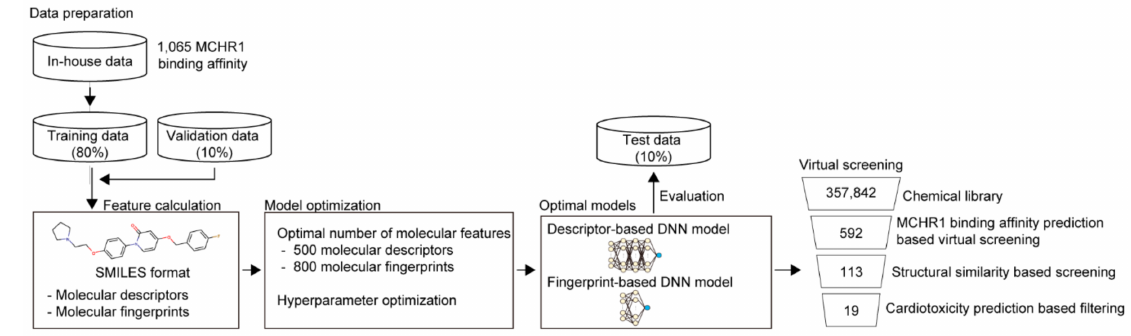
Figure 1. Overall scheme of virtual screening of MCHR1